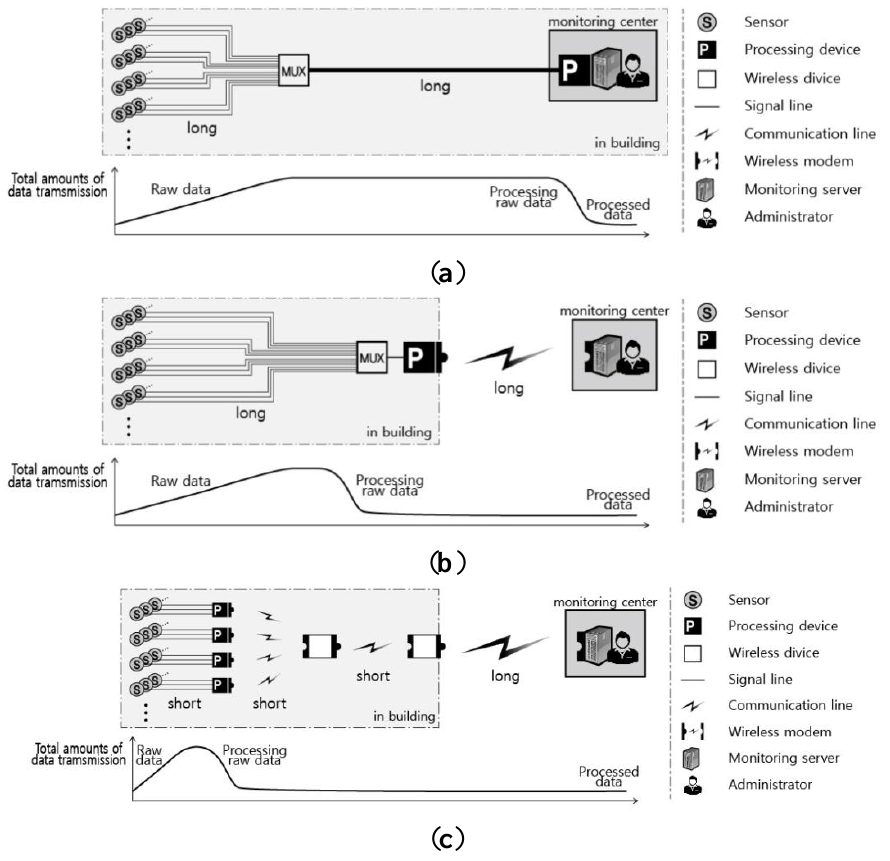
Figure 1. Sensor network ( a ) Wired sensor network; ( b ) Conventional wireless sensor network; ( c ) Proposed wireless sensor